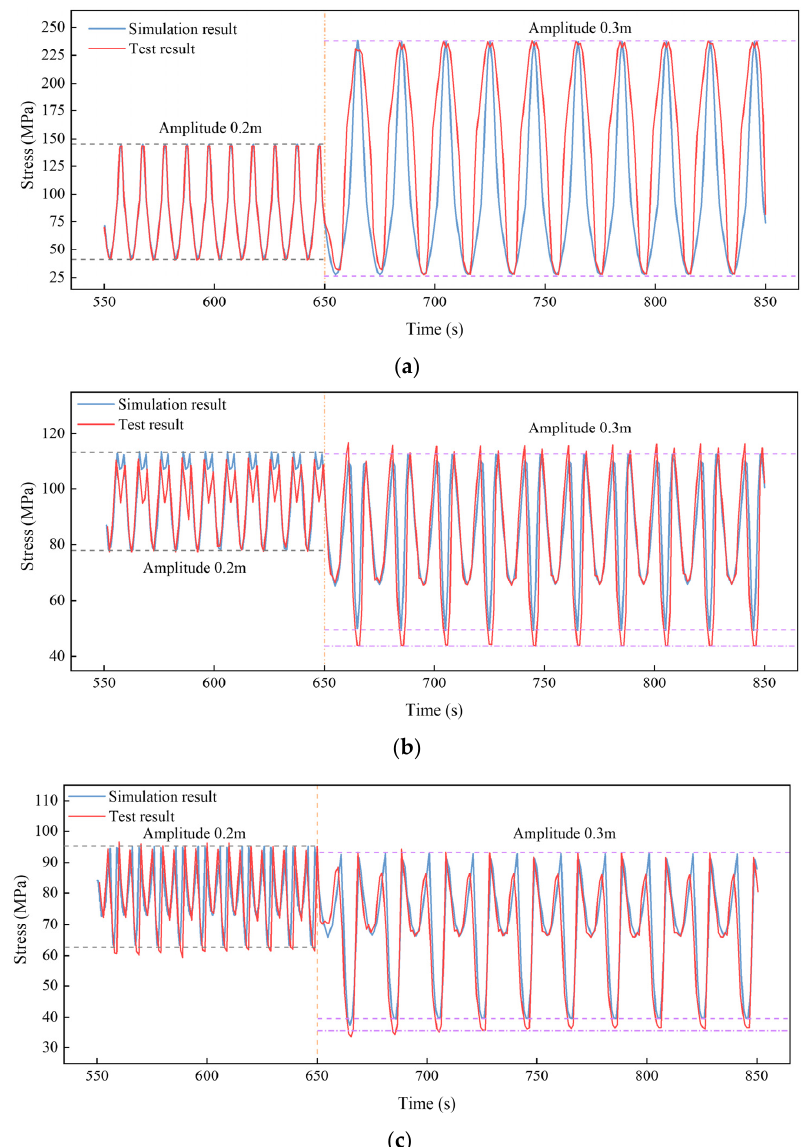
Figure 26. Time histories of the in-plane stress when the amplitude increased from 200 mm to 300 mm: ( a ) S2; ( b ) S5 and ( c ) S8.